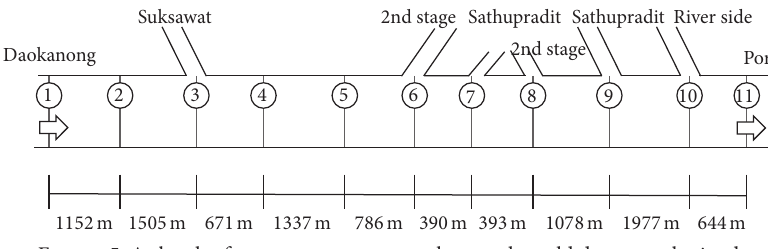
Figure 5: A sketch of expressway segment where real-world data was obtained.